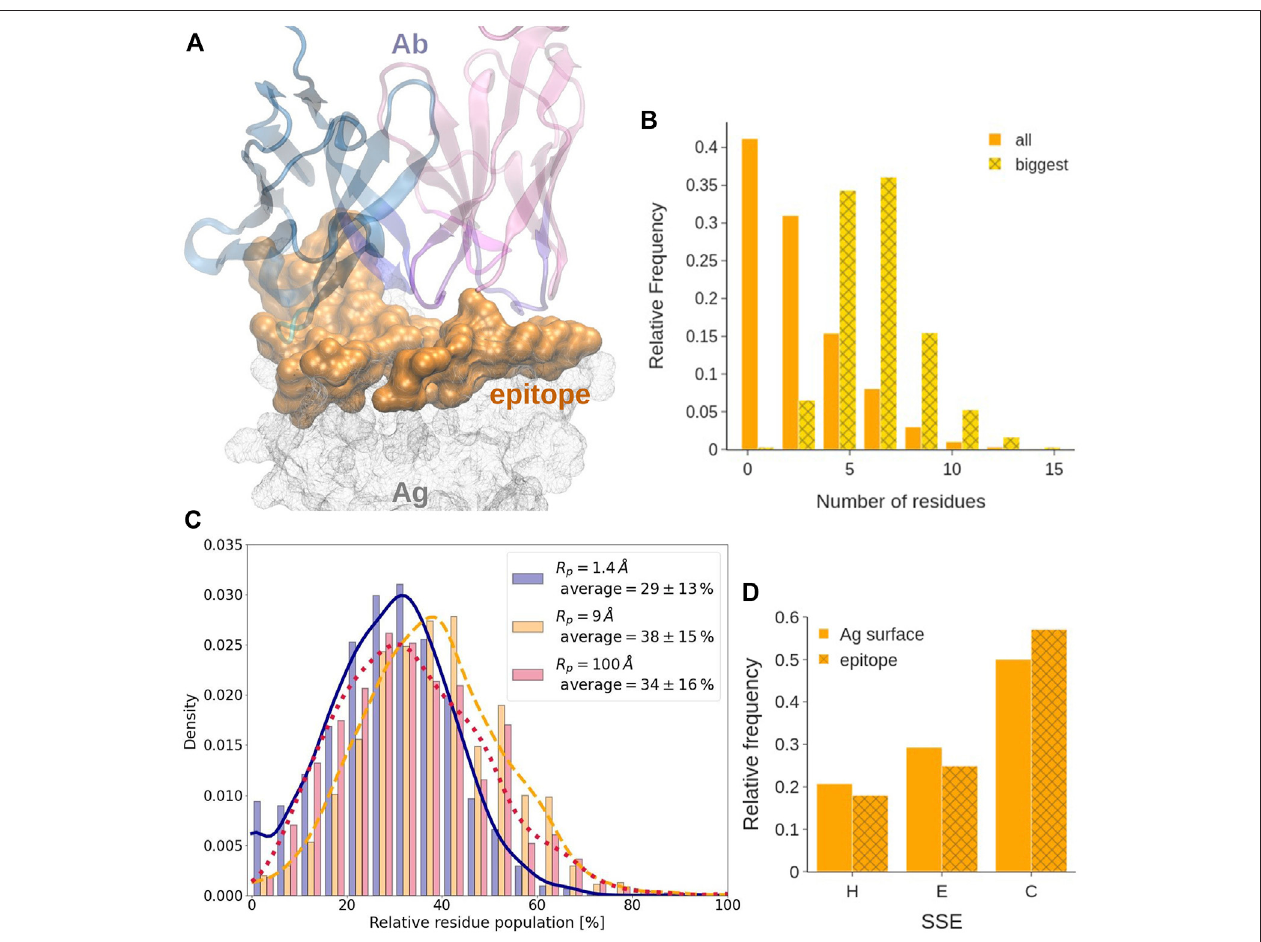
FIGURE 5 | Epitope analysis. (A) Covox-269 Fab interacting with the receptor binding domain of SARS-Cov-2 spike protein (PDB code: 7NEH) as representative structure of Ab-Ag complex. The antigen is represented as a solid surface. Color code: antibody heavy/light chains (cyan/magenta), epitope (orange). (B) Length, expressed in residue number, distribution in all sequential epitope stretches and in the longest one. (C) Distribution of the fraction of residues at the epitope exclusively exposed at each considered probe radius. (D) Distribution of the secondary structure of the epitope. The different secondary structure elements were grouped in helix (H), strand (E), and loops